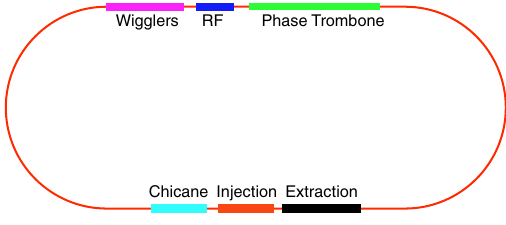
FIG. 15. ILC damping ring schematic